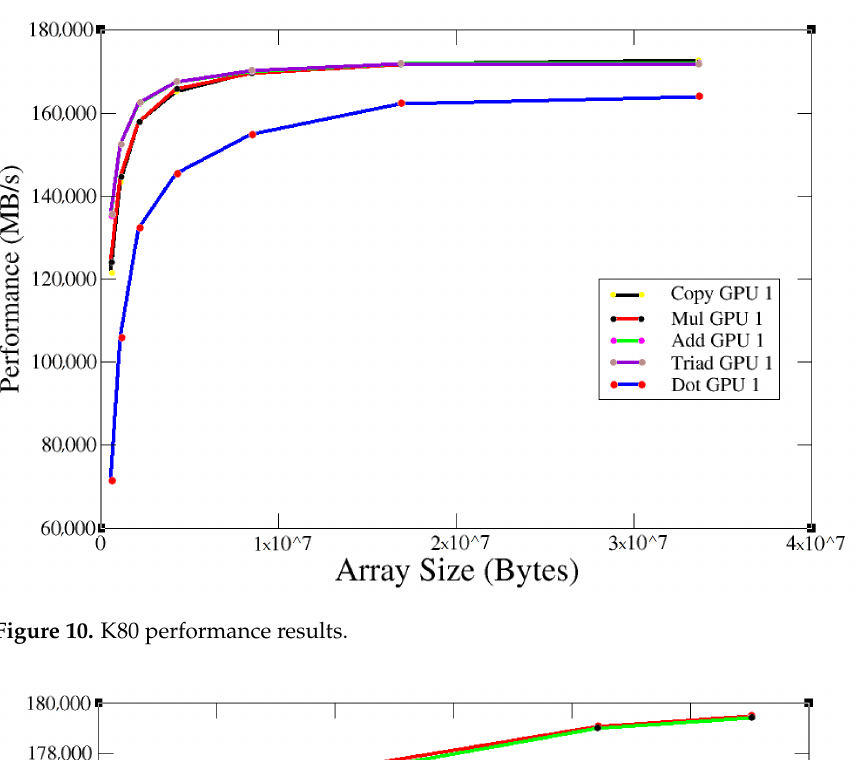
Figure 10. K80 performance results.